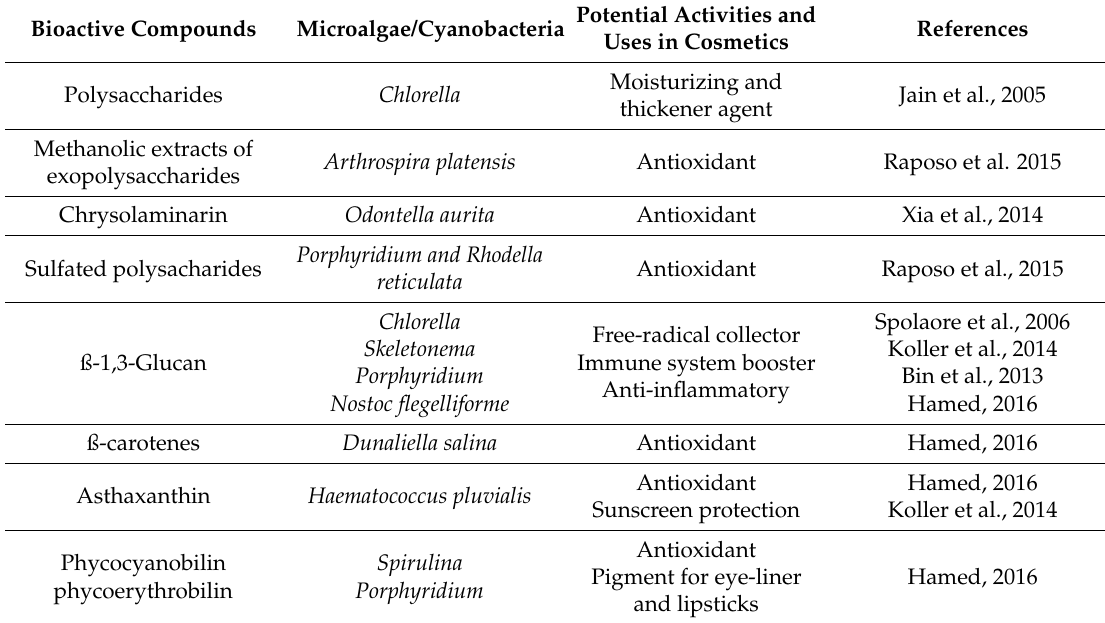
Table 1. Bioactive compounds from microalgae and cyanobacteria and their potential uses in cosmetics. Bioactive